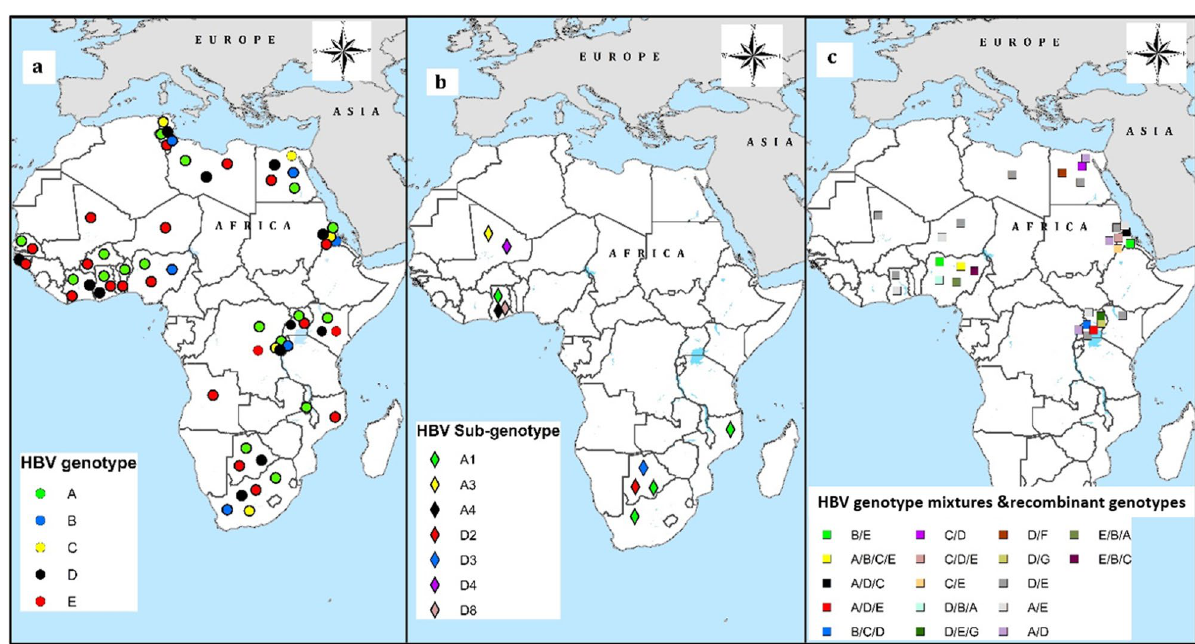
Figure 3. Relative distribution of the hepatitis B virus genotypes ( a ), sub-genotypes ( b ) and the recombinant genotypes ( c ) on the continent: Map was generated by using ArcMap 10.7.1 software (https:// deskt op. arcgis. com/ en/ arcmap/ 10.7/ get- start ed/ setup/ arcgis- deskt op- quick- start- guide.